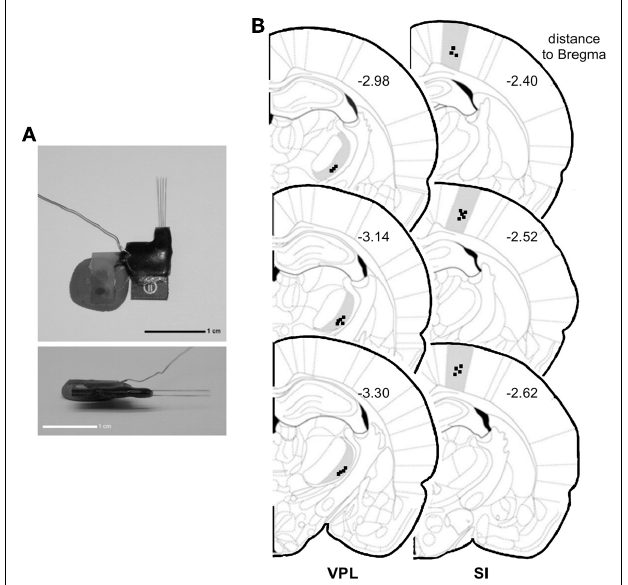
FIGURE 1 | Electrode construction and location of recordings. (A) Architecture of a microelectrode array used to record local field potentials (LFPs). (B) Coronal diagram illustrating the location of the LFPs recording sites ( dark squares ) in ventro-posterior-lateral thalamic nuclei (VPL) ( left side ) and in primary somatosensory cortex (SI) ( right side ). Numbers represent the rostro-caudal distance (in millimeters) relative to bregma